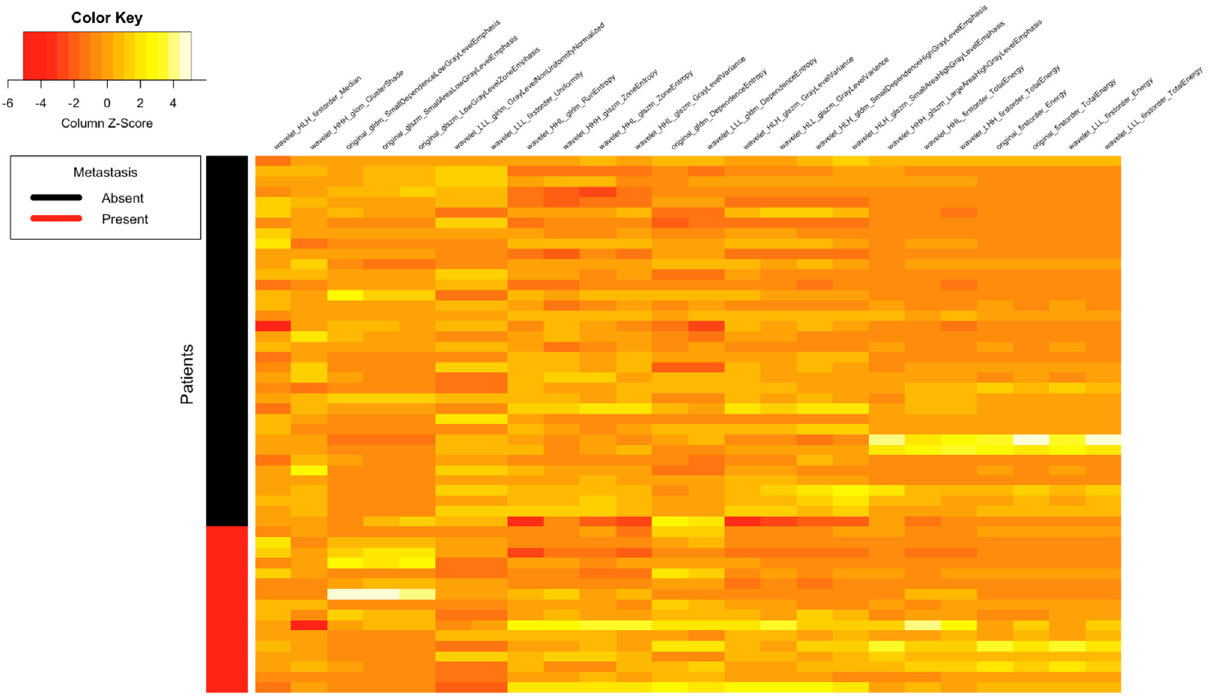
Figure 2. Heat map showing correlation between different radiomics and ADC features with the two classes of distant metastasis (absent and present).